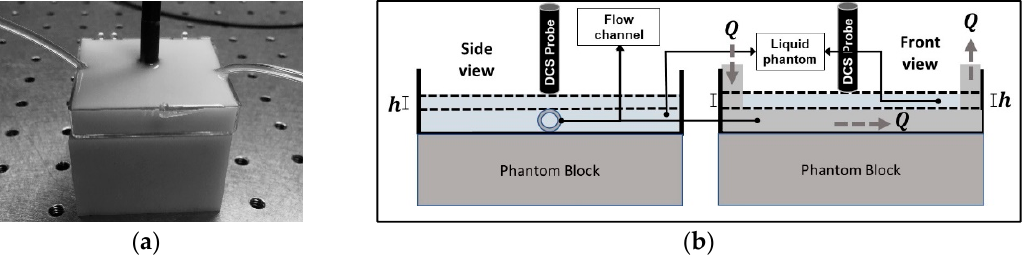
Figure 1. Photograph of the phantom flow chamber ( a ) and schematic of the flow chamber’s construction and measurement system ( b ). The gray arrows in ( b ) show the direction of the fluid flow. The flow rate F was controlled using a motorized syringe pump (see text). h is the distance from of the liquid surface to the top of the flow channel, which was controlled by addition of specific volumes of the liquid phantom to the chamber. The chamber (edges shown as thick black lines in ( b ) was placed atop a homogeneous tissue phantom block with optical properties matched to the liquid phantom at the laser wavelength. The DCS probe was positioned directly above the flow channel and at center of the flow chamber.